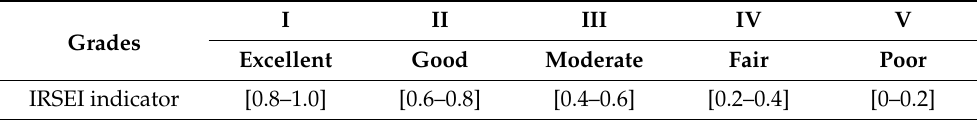
Table 4. Grades of ecological